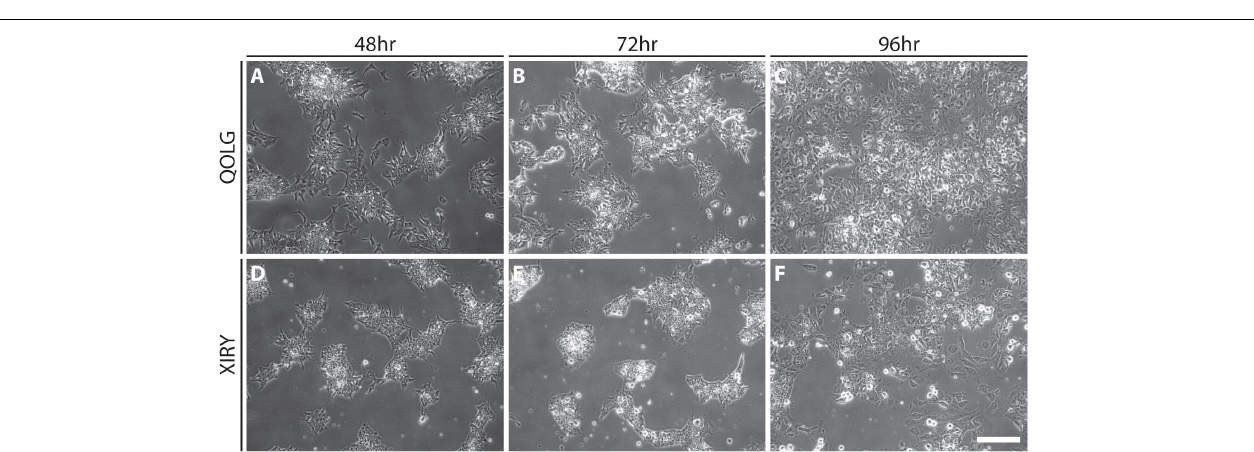
FIGURE 3 | Neural crest induction is delayed in BBS10 mutant cells. Phase contrast images of taken during neural crest induction at specified time points. Control QOLG (A–E) , mutant XIRY (F–J), and LAIG (K–O) cells. Discrete iPSC-like colonies can be seen at 24 h in all rows (B,G,L) . In control cultures, cells are seen delaminating from colonies at 48 h (blue arrowhead, C) ; whereas mutant cultures start showing delamination at 96 h (blue arrowheads, I,N) . By 120 h there are still some dense, colony-like regions present in all cultures (yellow arrowheads, E,J,O ). Scale bars = 50 µ m.